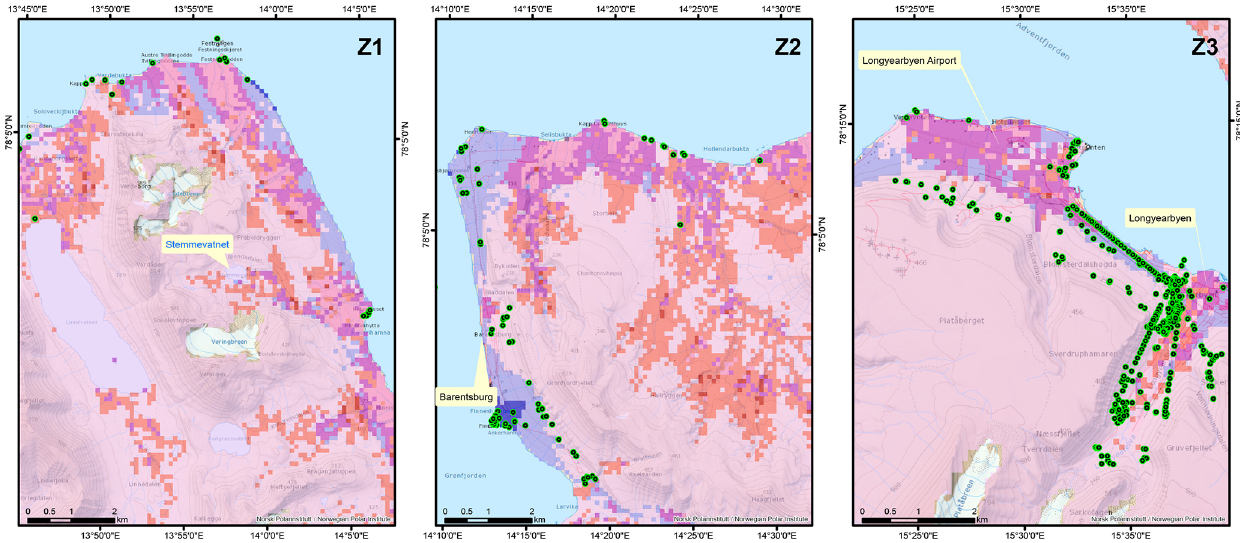
Figure 9. Multi-hazard map overlaps with zooms 1, 2, and 3 highlight portions of the territory where the two cryospheric hazards can interact with human activities, local infrastructure (in red and black lines), and protected cultural heritage (green